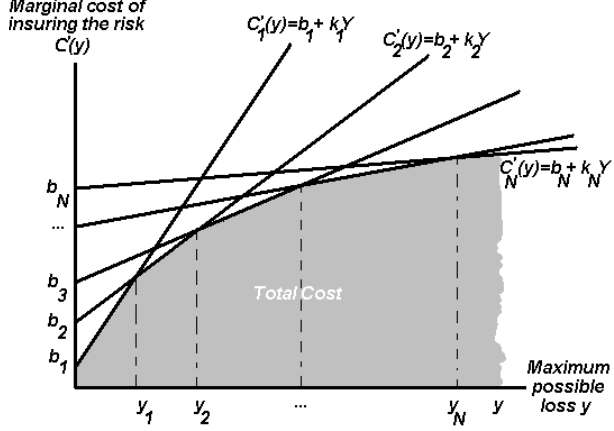
Fig. 3. Cost-minimizing contract with N